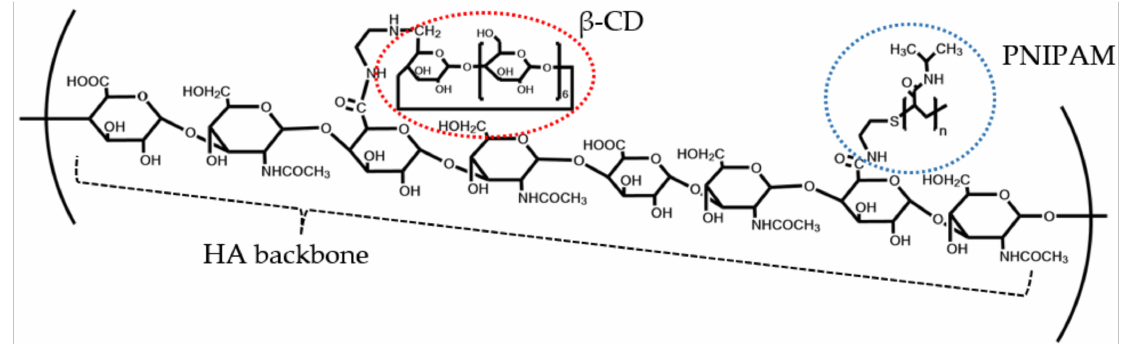
Figure 1. Chemical structure of PNIPAM and β -CD grafted onto HA backbone